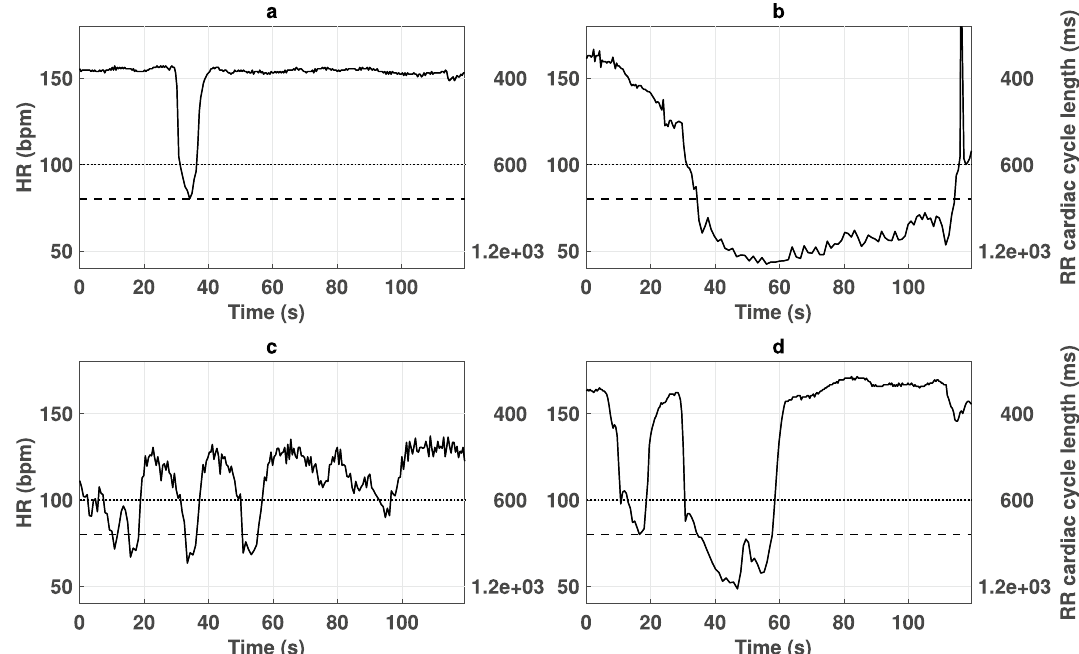
Figure 1. Example profiles of the observed bradycardia events. On each panel, solid curves represent the observed heart rate. Horizontal dotted and dashed lines represent respectively the yellow alarm threshold (100 bpm) and the red alarm threshold (80 bpm). Panel ( a ) shows a bradycardia of less than 100 bpm during at least 100 bpm 5 s ( B 5 s ). Panel ( b ) represents a severe bradycardia of less than 80 bpm during at least 10 s ( B ( c , d ) show triphasic and biphasic bradycardias annotated as single B